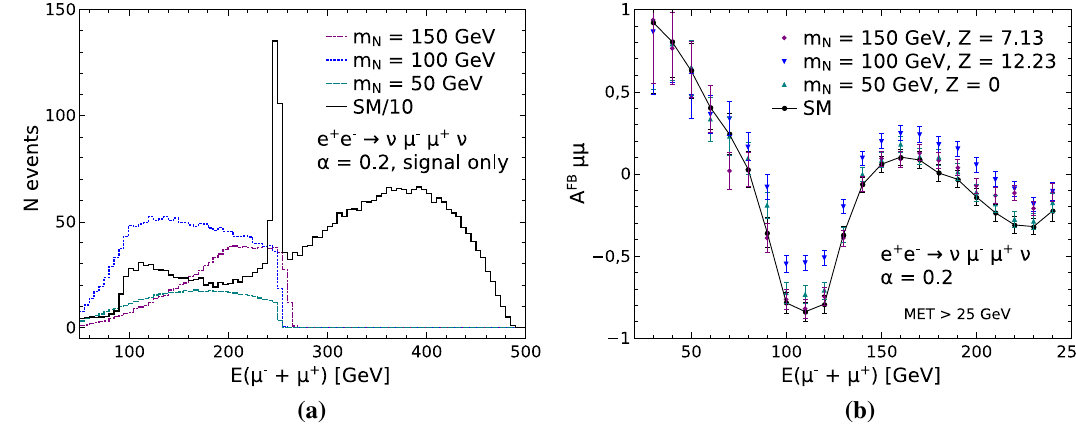
Fig. 3 Average (cid:15) R μμ ( a ) and A FB μμ ( b ) distributions with E μμ , signal-only (S) no cuts